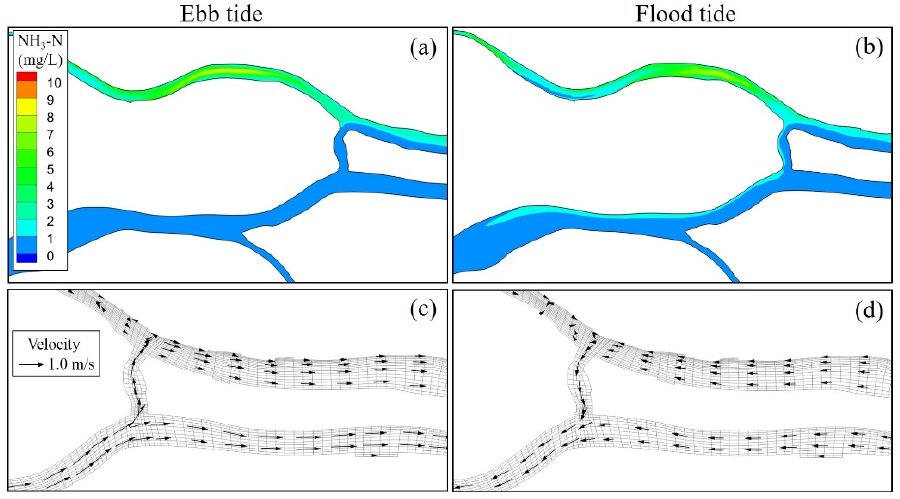
Figure 9. Distribution of ammonia and velocity at ebb tide ( a , c ) and flood tide ( b , d ) in a tidal cycle.